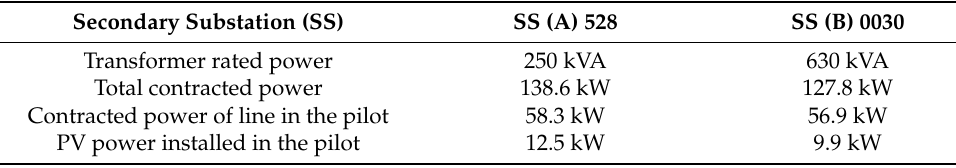
Table 1. Rated power and contracted power values of SS-528 and